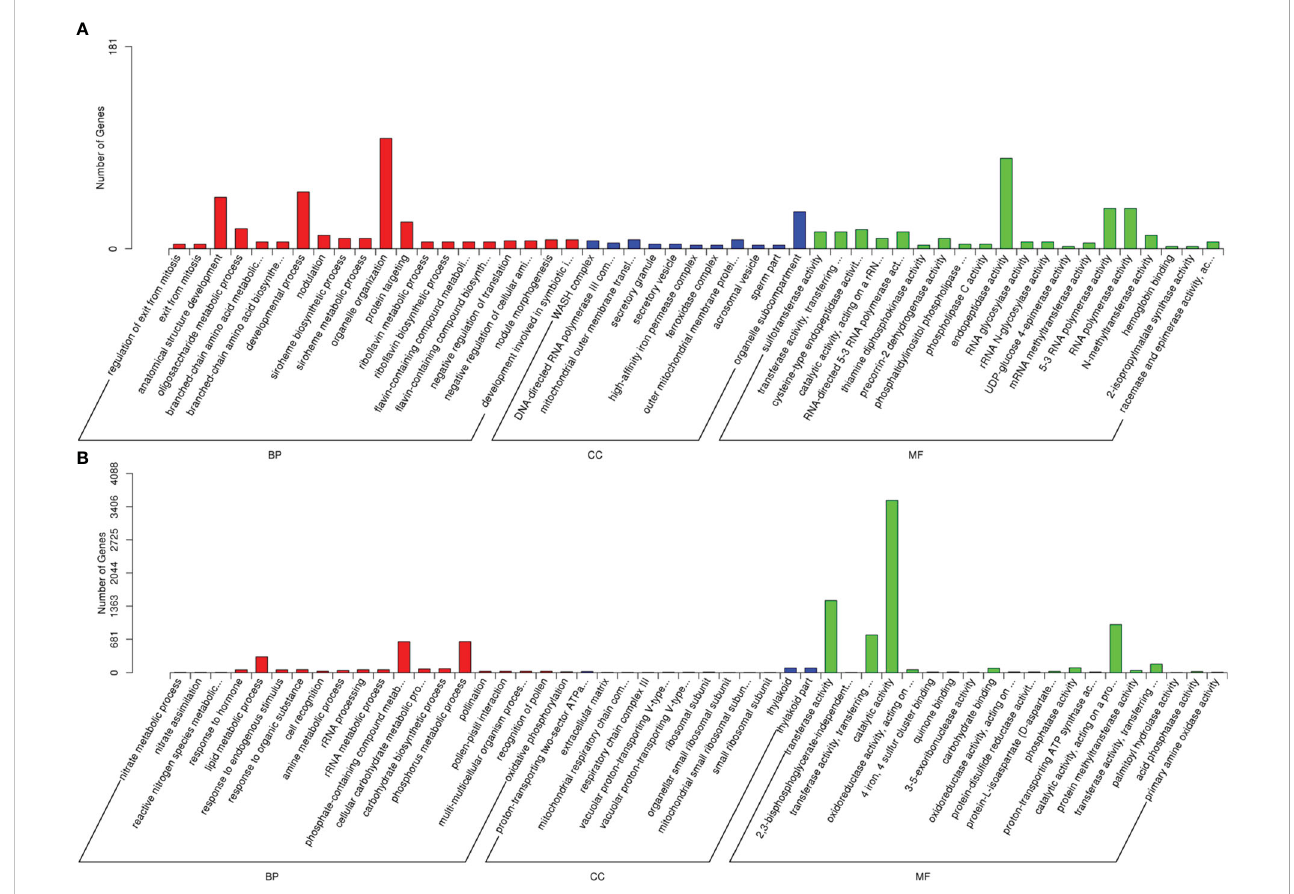
FIGURE 5 GO classi fi cation for the predicted target genes of DElncRNAs. (A) Go terms for cis-target genes. (B) Go terms for trans-target